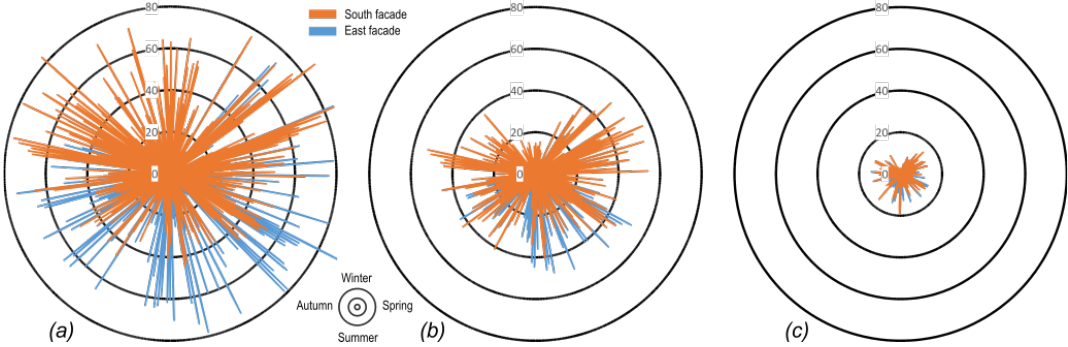
Figure 8. Yearly variation of the thermally induced temperature gradients (K) in London for values of view angles of 0° ( a ), 30° ( b ) and 60° ( c ) for the worst combination of glass type/insulation type in Tables 7 and 8.